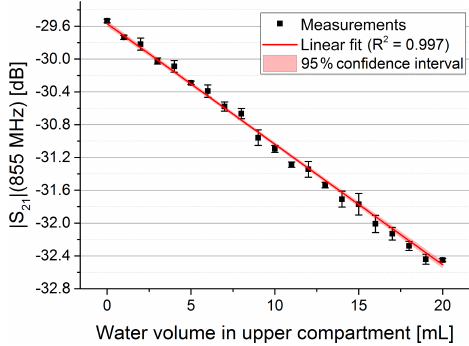
Figure 4. Magnitude at constant frequency vs. water volume pushed in the upper compartment. The data were fitted with a linear fit (red curve) yielding R 2 = 0 . 997.